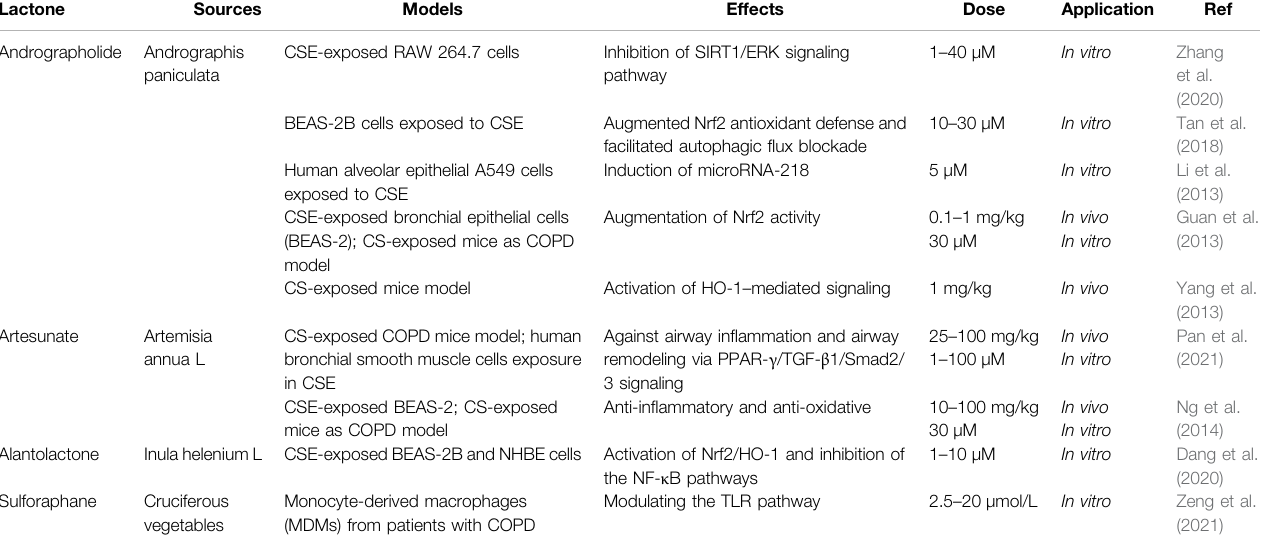
TABLE 6 | The effects of lactone on